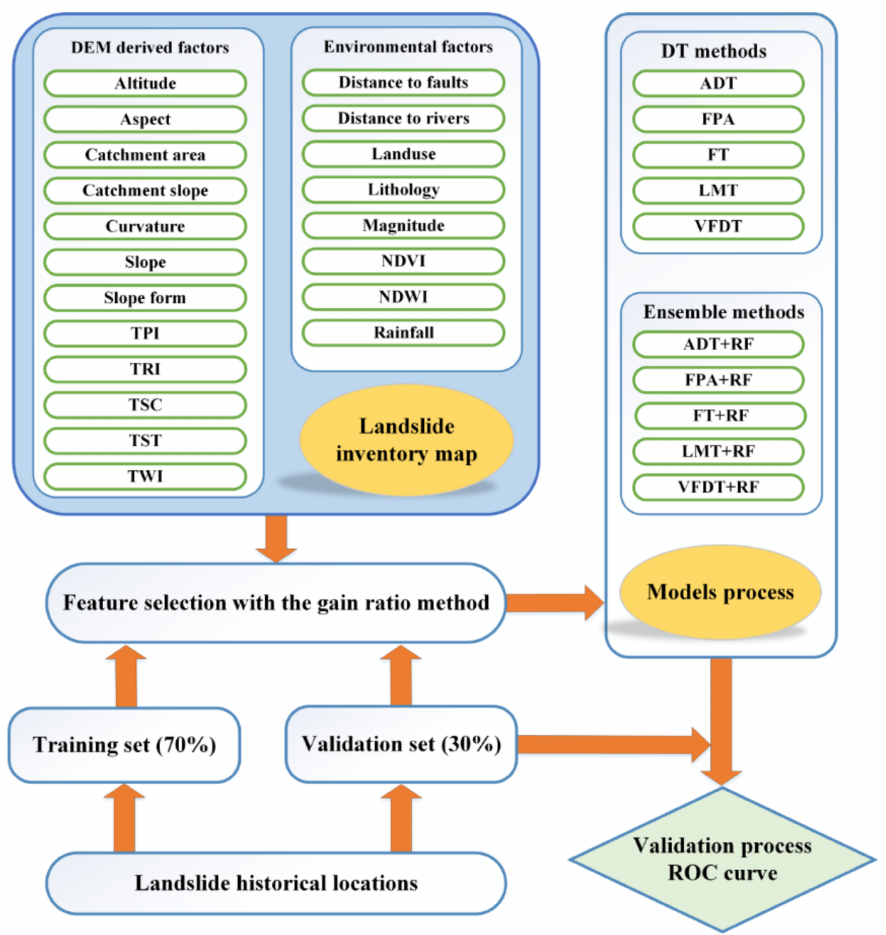
Figure 2. The flowchart of the proposed ensemble framework. The terrain position index (TPI), terrain ruggedness index (TRI), terrain surface convexity (TSC), terrain surface texture (TST), topographic wetness index (TWI), normalized difference vegetation index (NDVI), and normalized difference water index (NDWI) are landslide conditioning factors. The alternating decision tree (ADT), forest by penalizing attributes (FPA), functional tree (FT), logistic model tree (LMT), and Hoeffding tree (VFDT) are base classifiers. RF is the rotation forest ensemble